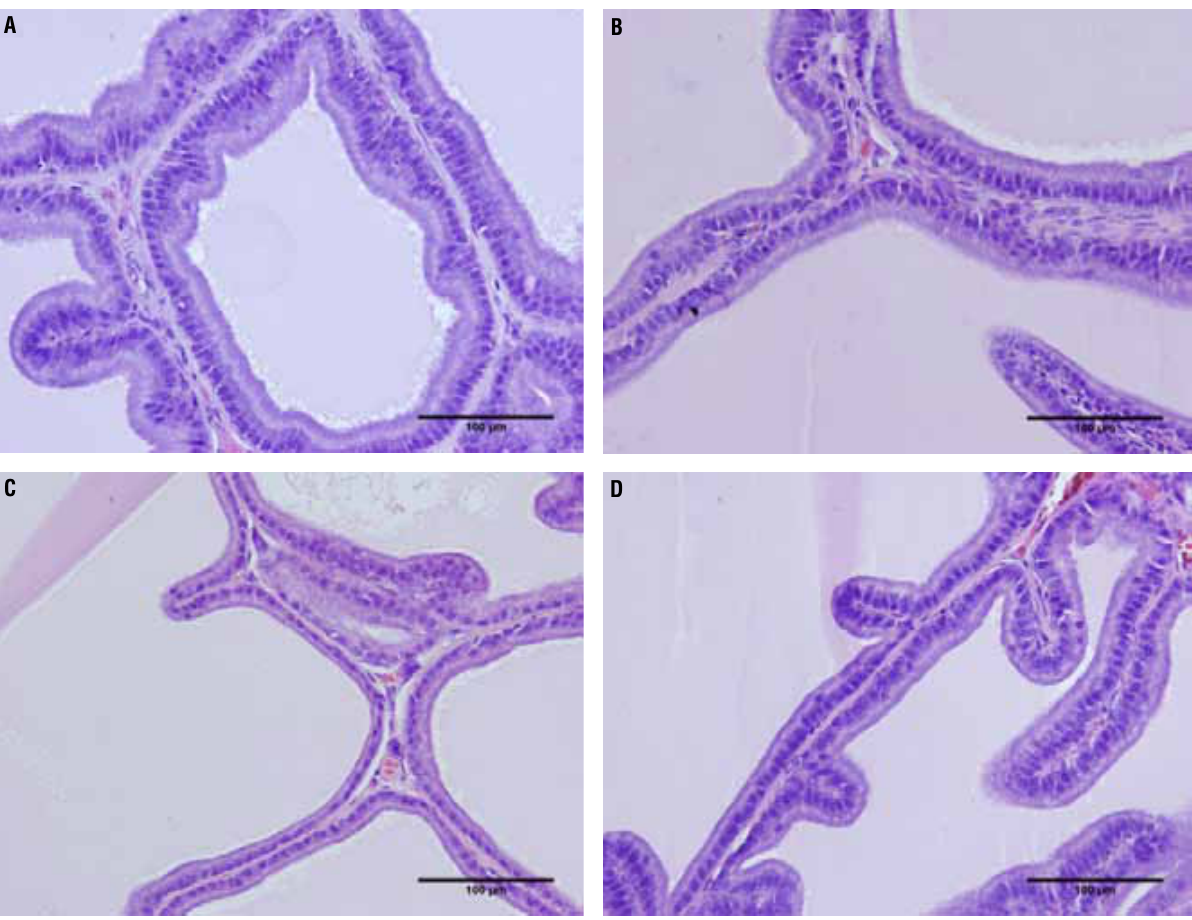
Figure 3 - Photomicrographs of the rat prostate ventral lobe group showing the epithelium height. The epithelium height showed no difference between groups C65 and T65, but the T105 group showed an increased of 32% compared to C105. A) Rat prostate ventral lobe of group C65. HE 400x. B) Rat prostate ventral lobe of group T65 HE 400x. C) Rat prostate ventral lobe of group C105 HE 400x. D) Rat prostate ventral lobe of group T105 HE